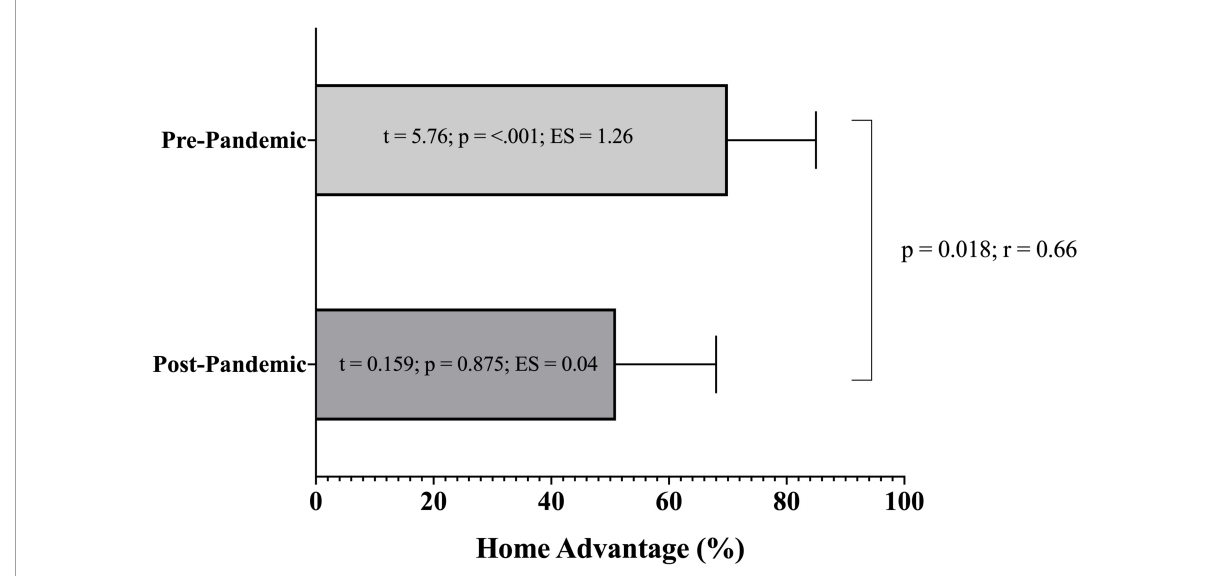
FIGURE1 Analysis of home advantage (HA) according to the pre-pandemic and pandemic